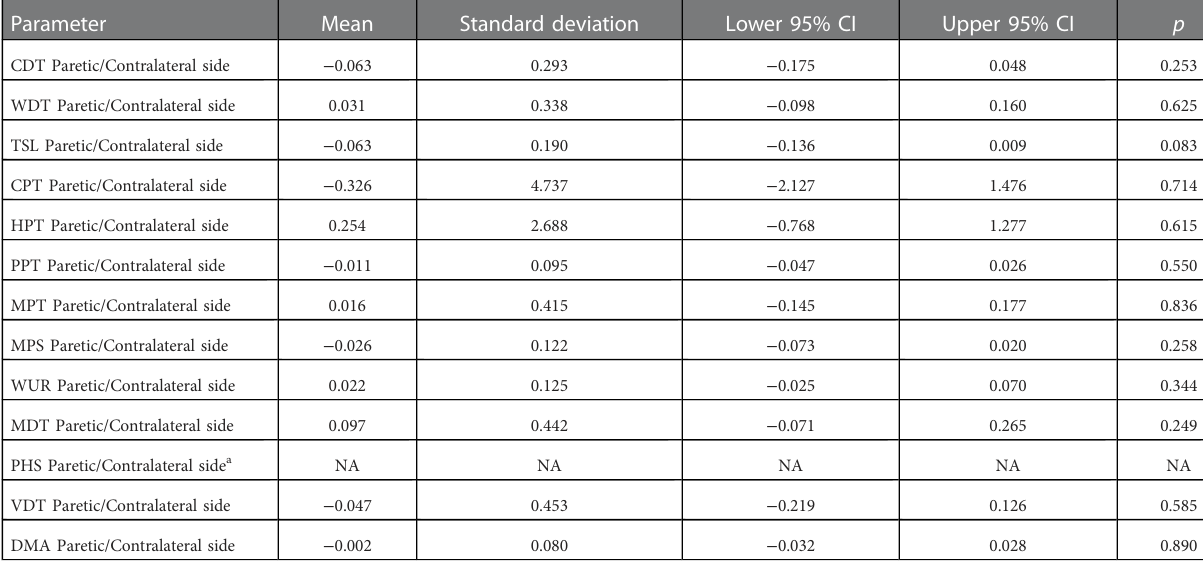
TABLE 3 Comparison of the z -scores of the differences between the paretic and contralateral sides.